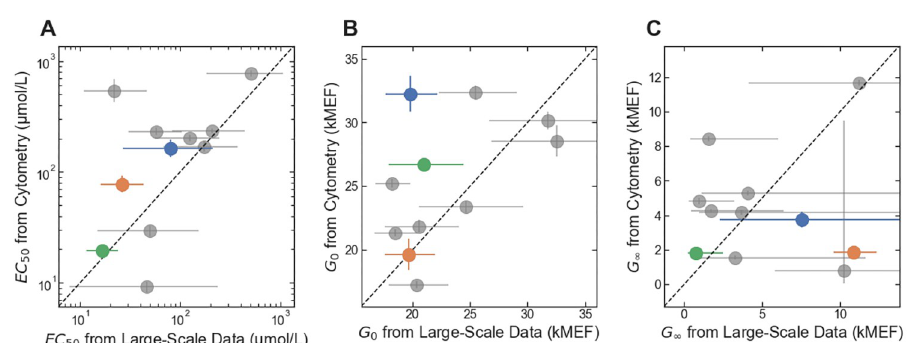
Fig 6. Accuracy of large-scale measurement for inverted variants. (A) EC 50 from the flow cytometry measurements plotted vs. EC 50 from the large-scale dataset. (B) G 0 from the flow cytometry measurements plotted vs. G 0 from the large-scale dataset. (C) G 1 from the flow cytometry measurements plotted vs. G 1 from the large-scale dataset. In all three plots, results for the inverted variants selected to have specified EC 50 are plotted with markers colored to match the results in Fig 4; results for additional inverted variants are plotted with gray markers. Error bars indicate ± one standard